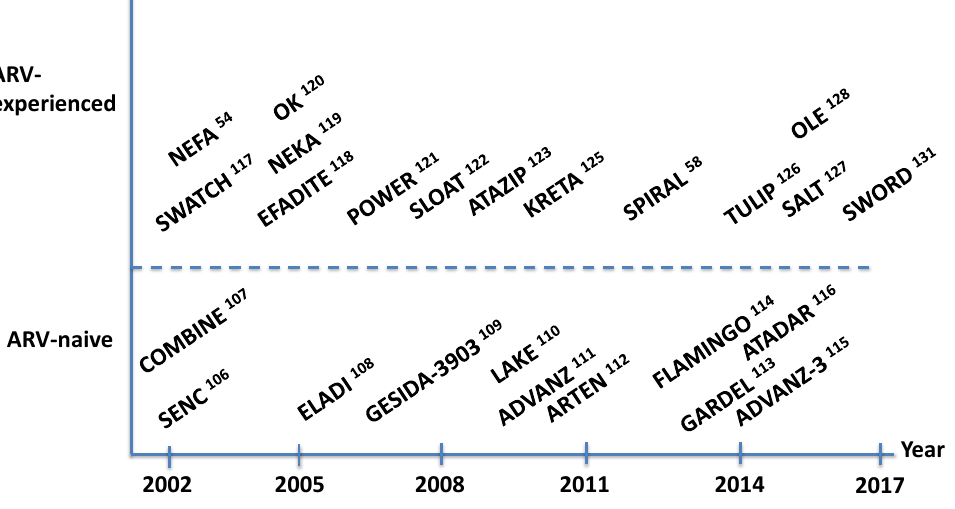
Figure 5. Major prospective clinical trials on antiretroviral therapy in adults led by Spanish